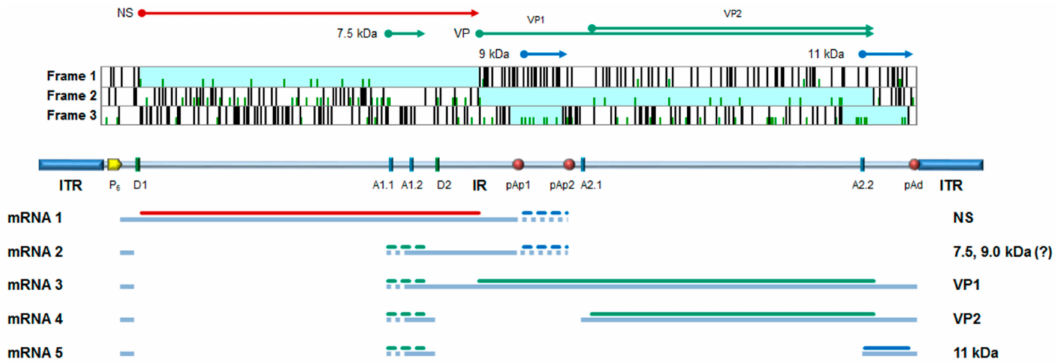
Figure 1. B19V genome organization. Top: major open reading frames identified in the positive strand of genome; arrows indicate the coding sequences for the viral proteins. NS, non-structural protein; VP, structural proteins, colinear VP1 and VP2, assembled in a T = 1 icosahedral capsid; and 7.5 kDa, 9.0 kDa, and 11 kDa: minor non-structural proteins. Center: a schematic diagram of B19V genome indicating the two inverted terminal regions (ITR), and the internal region (IR) with the distribution of cis-acting functional sites (P6, promoter; pAp1, pAp2, proximal cleavage-polyadenylation sites; pAd, distal cleavage-polyadenylation site; D1 and D2, splice donor sites; A1.1, A1.2, A2.1, and A2.2, splice acceptor sites). Bottom: simplified transcription map of B19V genome, indicating the five classes of mRNAs (mRNA 1–5) with respective alternative splicing / cleavage forms (dashed), and their coding potential. Adapted from Reference